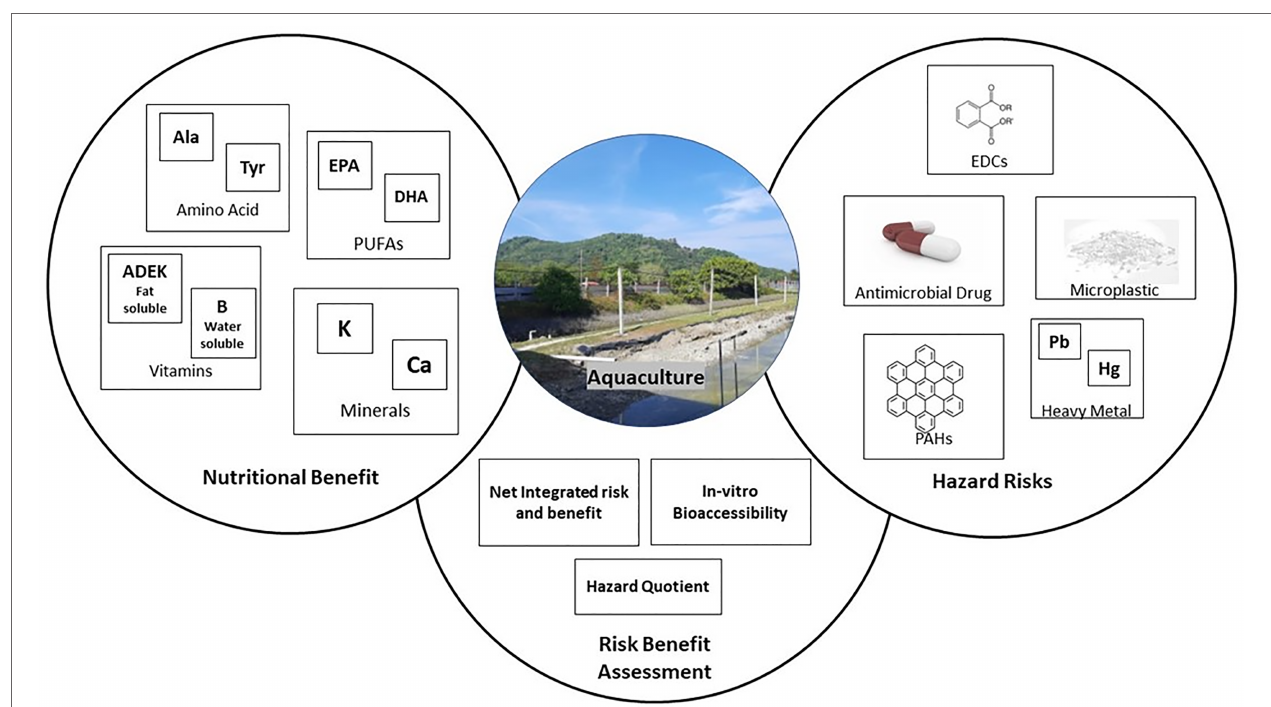
FIGURE 3 | The correlation of risk and benefit assessment in aquaculture